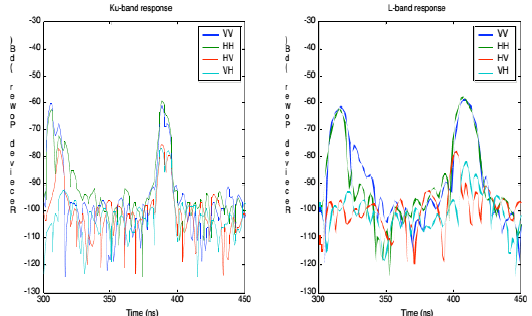
Figure 3. Ku and L band time domain responses of